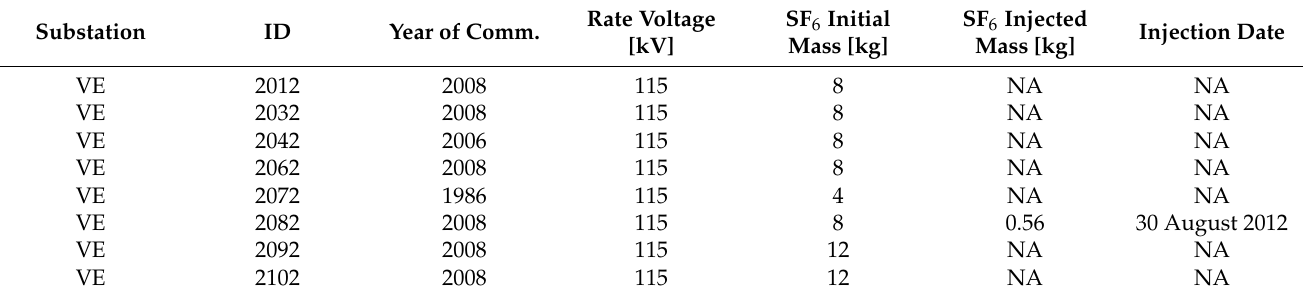
Table 1. Current fleet data example.